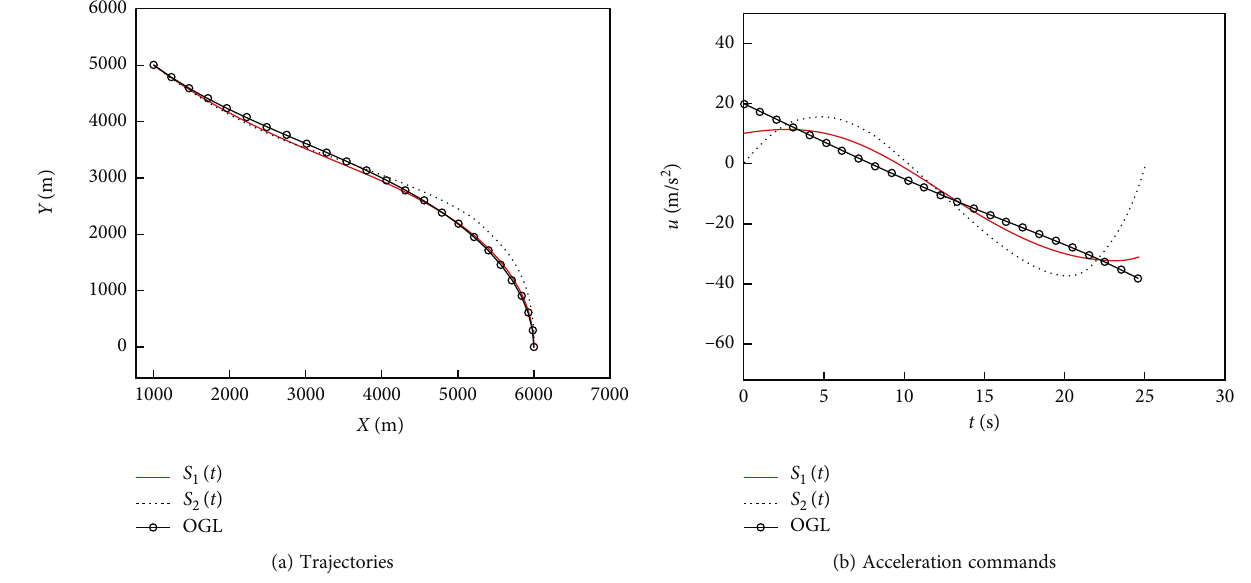
ð 0 Þ = − 45 ° , γ = − 90 ° f m